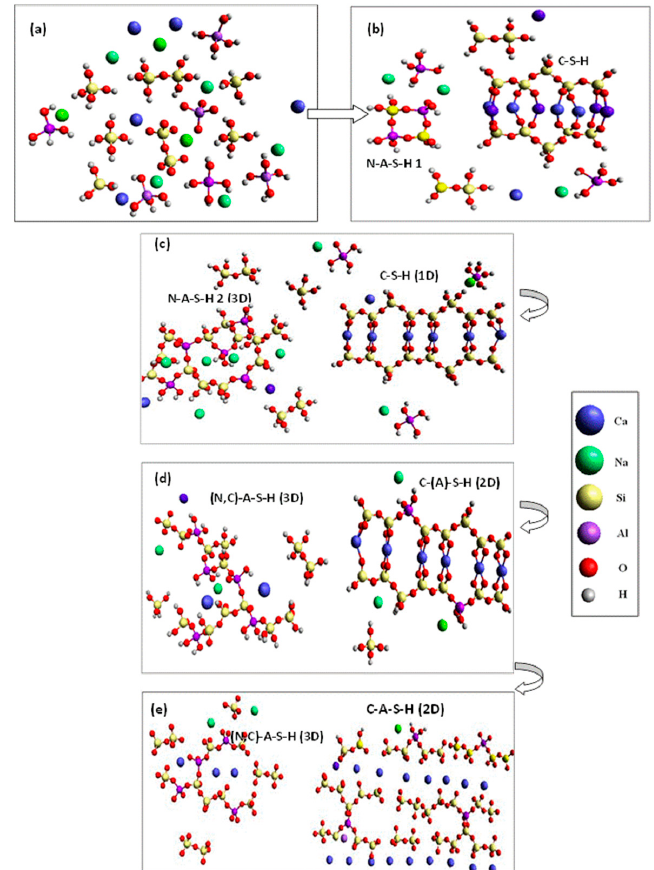
Figure 6. Nano-structural mechanism for gel formation in hybrid alkaline cements; ( a ) dissolution of